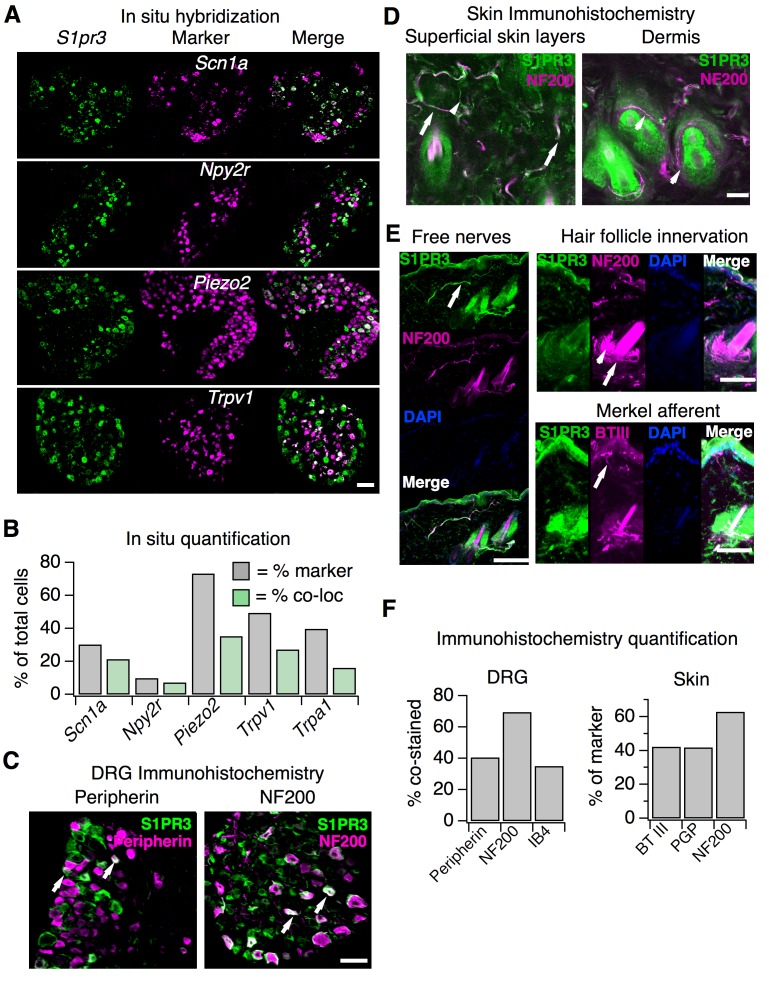
S1pr3 is expressed in A mechanonociceptors and C thermal nociceptors.(A) (Top) Representative co-ISH of S1pr3 (green; left) with Scn1a, Npy2r, Piezo2, and Trpv1 (magenta; center) in sectioned DRG. Right column: overlay with co-localized regions colored white (10x air objective; scale = 100 µm). (B) Bar chart showing the % of total cells expressing the indicated marker (grey) and the % of total cells co-expressing both marker and S1pr3 (green). See Table S1 for quantification. (C) Representative IHC images of sectioned DRG from S1pr3mCherry/+ animals stained with anti-DsRed (green, S1PR3) and anti-Peripherin (left, magenta) or anti-NF200 (right, magenta). Arrows indicate co-stained cells. Images were acquired using a 10x air objective (scale = 100 µm). (D) Whole-mount skin IHC confocal images with anti-DsRed antibody (S1PR3, green) and anti-NefH antibody (NF200, magenta) in an S1pr3mCherry/+ animal (20x water objective; scale = 50 µm). Arrows indicate co-positive free nerves (left image). Arrowheads indicate NF200- free nerves (left) or S1PR3- circumferential fibers (right image). (E) Sectioned skin IHC with anti-DsRed (S1PR3) and anti-NefH (NF200, left, top right) or anti-DsRed (S1PR3) and anti-beta-tubulin III (BTIII, bottom right) antibody (magenta) in S1pr3mCherry/+ skin (20x air objective; scale = 50 µm). Arrows indicate co-positive free nerve endings (left), S1PR3-negative lanceolate/circumferential hair follicle endings (top right, arrow = circumferential, arrowhead = lanceolate), or S1PR3-negative putative Merkel afferent (bottom right). (F) (Left) Quantification of sectioned DRG IHC experiments showing % of S1PR3+ cells that co-stained with indicated markers (n > 250 cells per marker). (Right) Quantification of sectioned skin IHC experiments showing % of fibers positive for indicated marker that co-stained with S1PR3 (anti-DsRed; n = 10 images per marker from two animals).